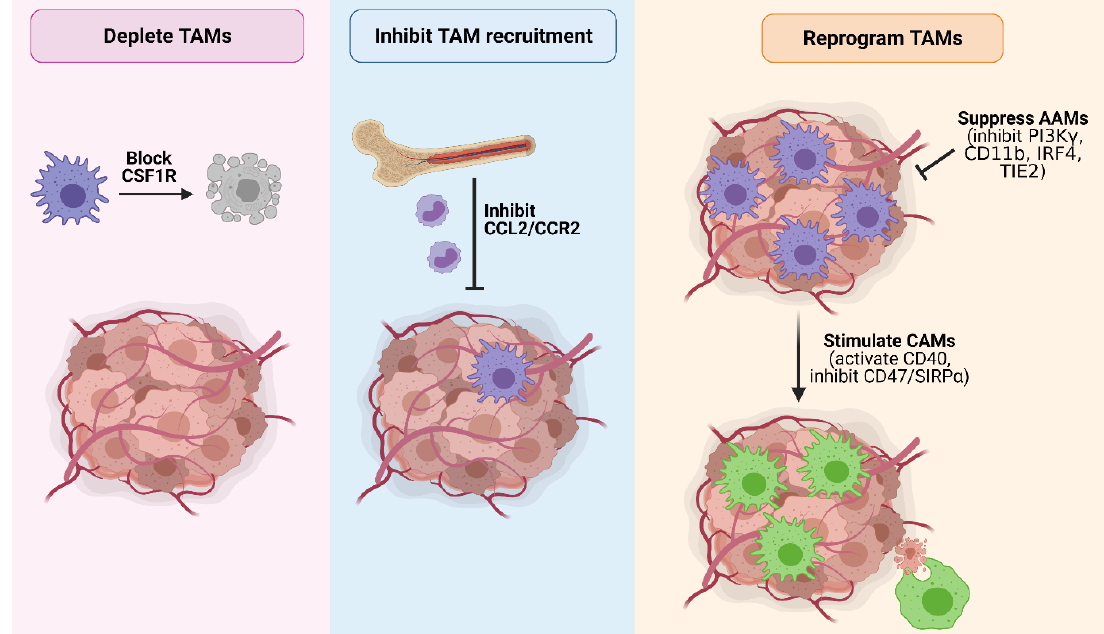
Figure 4. Strategies to therapeutically target TAMs in PDAC. Major TAM-targeting strategies in PDAC include (1) TAM depletion by blocking CSF1R signaling; (2) inhibition of TAM recruitment by blocking CCL2/CCR2 signaling; (3) suppressing the pro-tumorigenic activity of AAMs by inhibiting PI3Kγ, CD11b, IRF4 or TIE2; and (4) reprogramming TAMs towards a tumoricidal classically-activated endotype via CD40 agonists or inhibition of the ‘do not eat me’ CD47/SIRPα signaling axis to promote tumor cell phagocytosis. Figure created in Biorender.